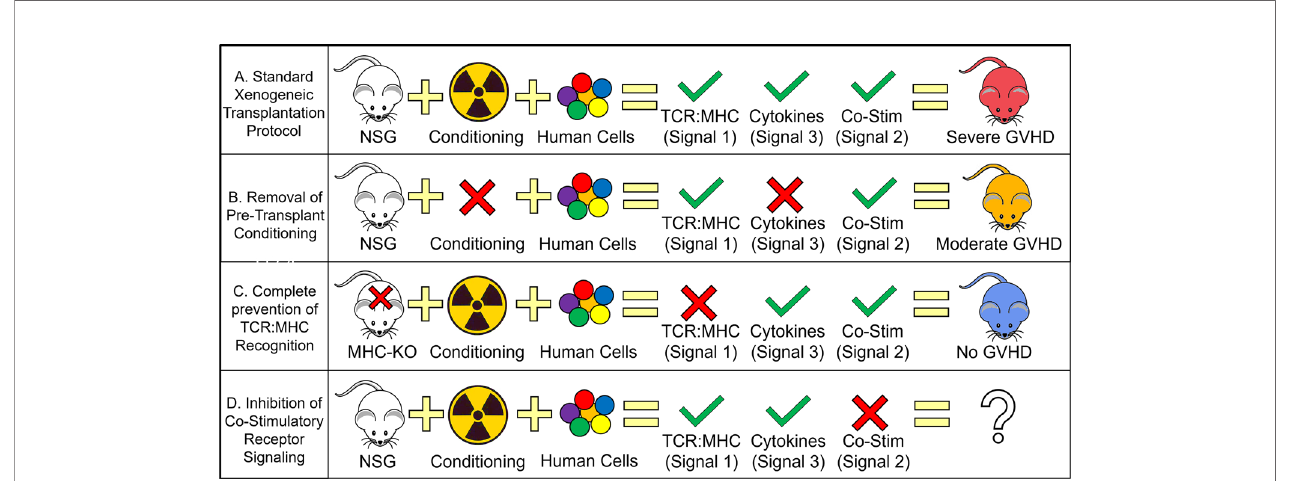
FIGURE 1 | Human T cell Requirements for GVHD Development During Xenogeneic Transplantation. Schematic depicting the relative contribution of each T cell activation signal toward the development of GVHD. (A) Standard xenogeneic transplant protocols provide all three T cell activation signals, human TCR to murine MHC recognition, pro-in fl ammatory cytokine secretion from genotoxic conditioning (i.e. g -irradiation) and human CD28 to murine B7 cross-reactivity (with possible contributions from other co-stimulatory proteins) to cause severe GVHD. (B) Removing the presence of pro-in fl ammatory cytokines by not conditioning NSG mice prior to transplant results in only a slight decrease in GVHD severity with clinical data using tocilizumab/ruxolitinib also showing modest effects on GVHD mitigation. (C) Complete prevention of human TCR recognition of murine MHC (by knocking out murine MHC) eliminates all signs of GVHD. The widespread adoption of calcineurin inhibitors (e.g. tacrolimus) for GVHD prophylaxis also supports the important role of TCR : MHC interactions though in the case of clinical calcineurin inhibitors, only a partial inhibition is achieved. (D) Blocking co-stimulatory signaling remains the only T cell activation signal not investigated with xenogeneic transplant studies and is only recently entered the clinical domain. Severe GVHD is generally described as achieving ≥ 70% lethality with 3E 6 PB-MNC with moderate GVHD ranging from 30-70% lethality with the same dose of human